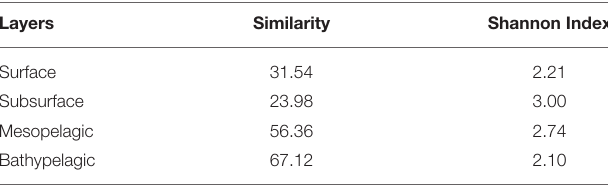
TABLE 3 | Similarity and Shannon index in each layer group estimated based on the 16S rRNA